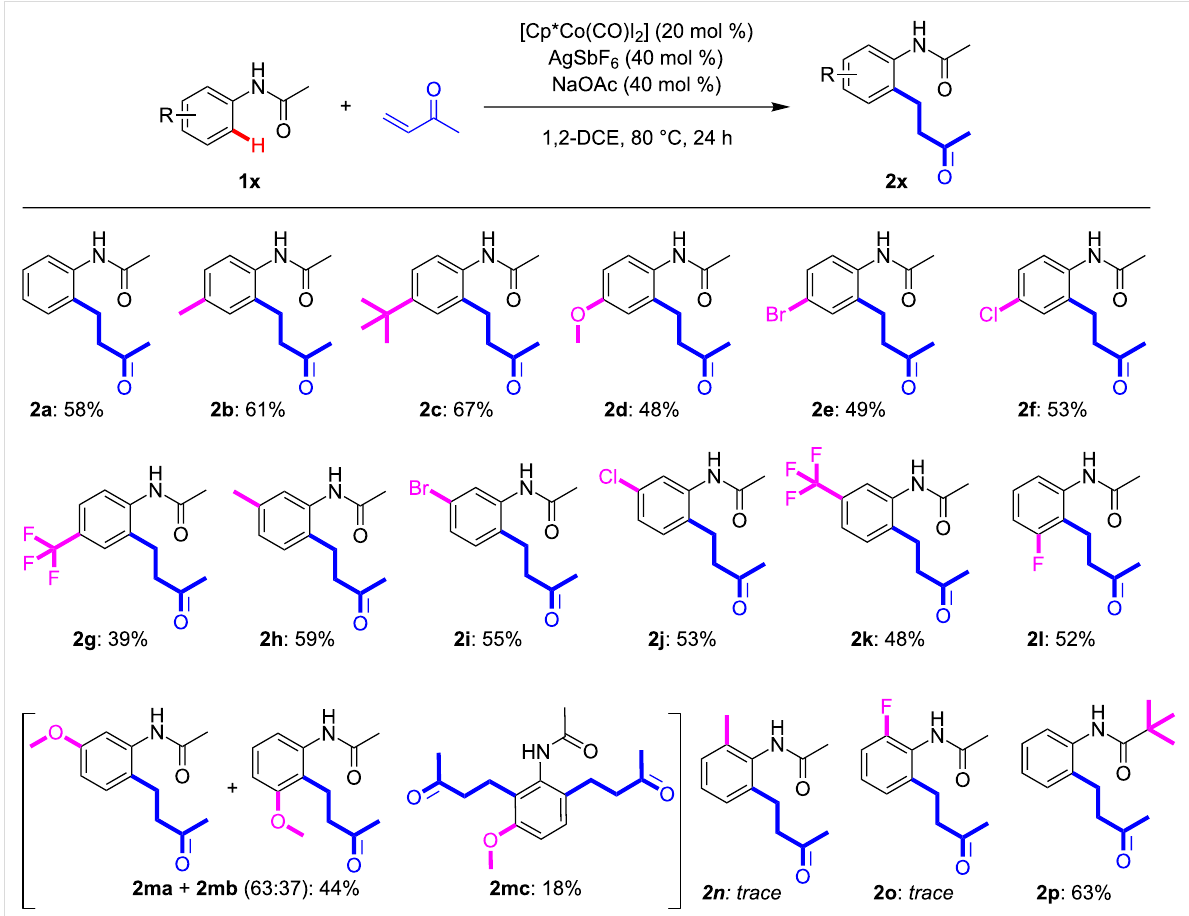
Scheme 3: Substrate scope of Cp*Co(III)-catalysed coupling of 3-buten-2-one with functionalised acetanilides. All reactions carried out on a 1.0 mmol scale with isolated yields